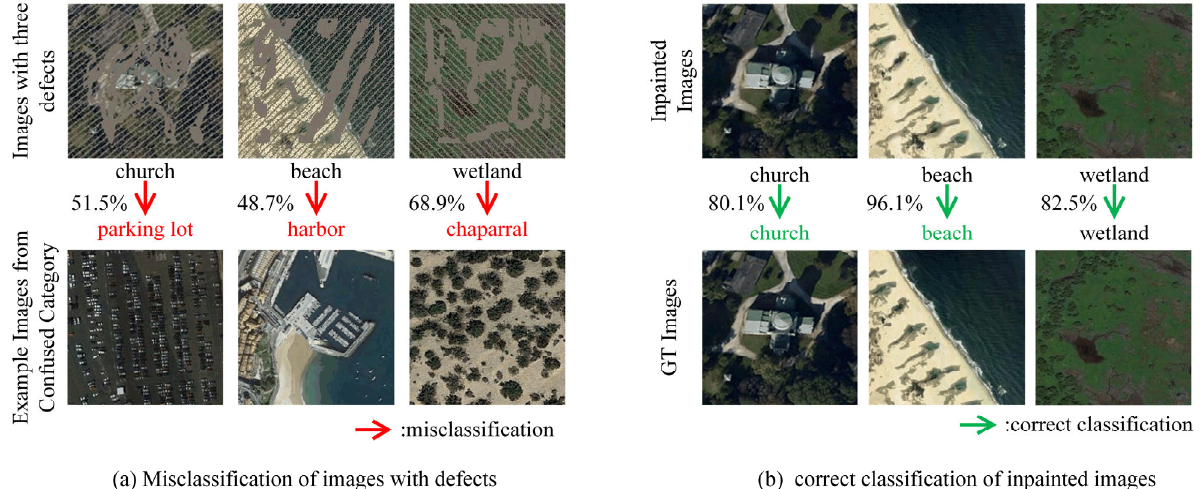
Figure 20. The visualized explanation of the confusion matrix. ( a ) Defect images are misclassified mainly into three categories. ( b ) The inpainted images can be classified correctly.